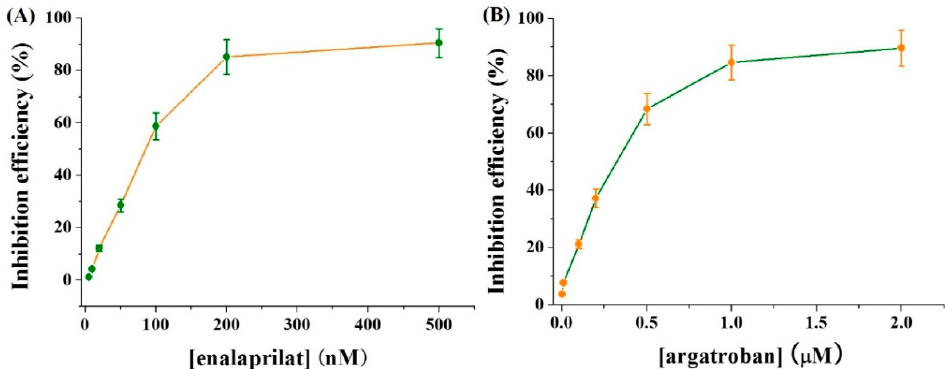
Figure 6. Effect of enlaprilat ( A ) and argatroban ( B ) concentration on the inhibition efficiency. The concentrations of ACE and thrombin were 50 and 100 mU/mL, respectively.